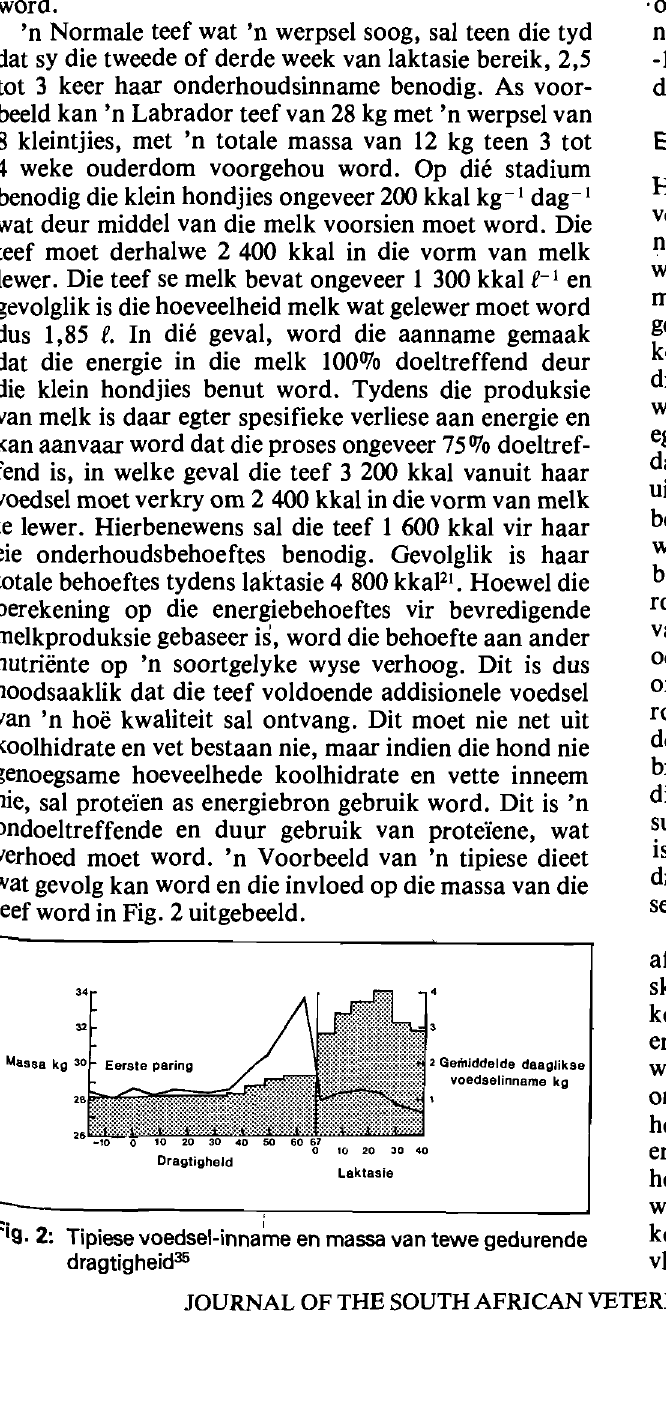
Fig. 2: Tipiese voedsel-inna~e en massa van tewe gedurende dragtigheid